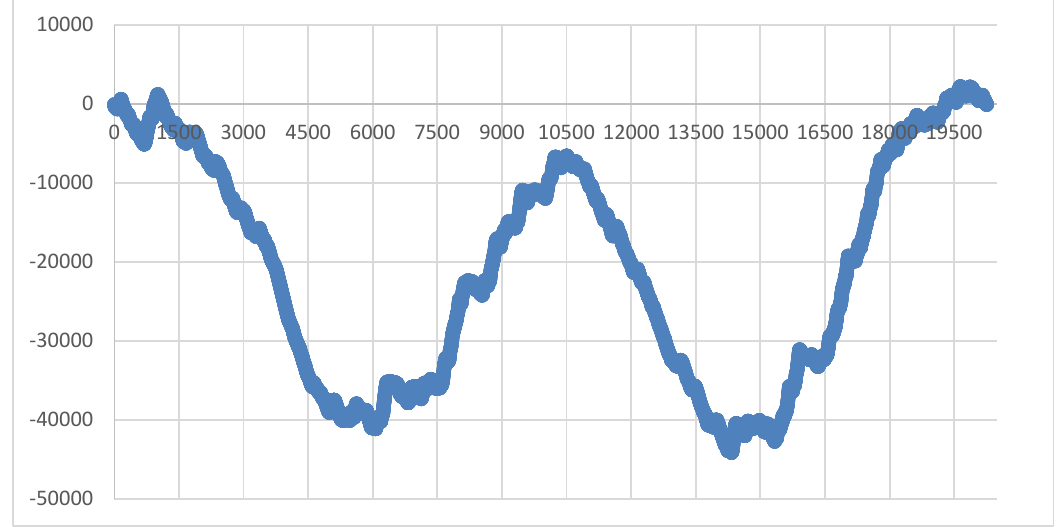
Figure 11. CUSUM chart of data between January 2014 and June 2016. Replacing these data with monthly average values smoothed the fluctuations and better outlined the seasonal trends of the data as shown in Figure 12.